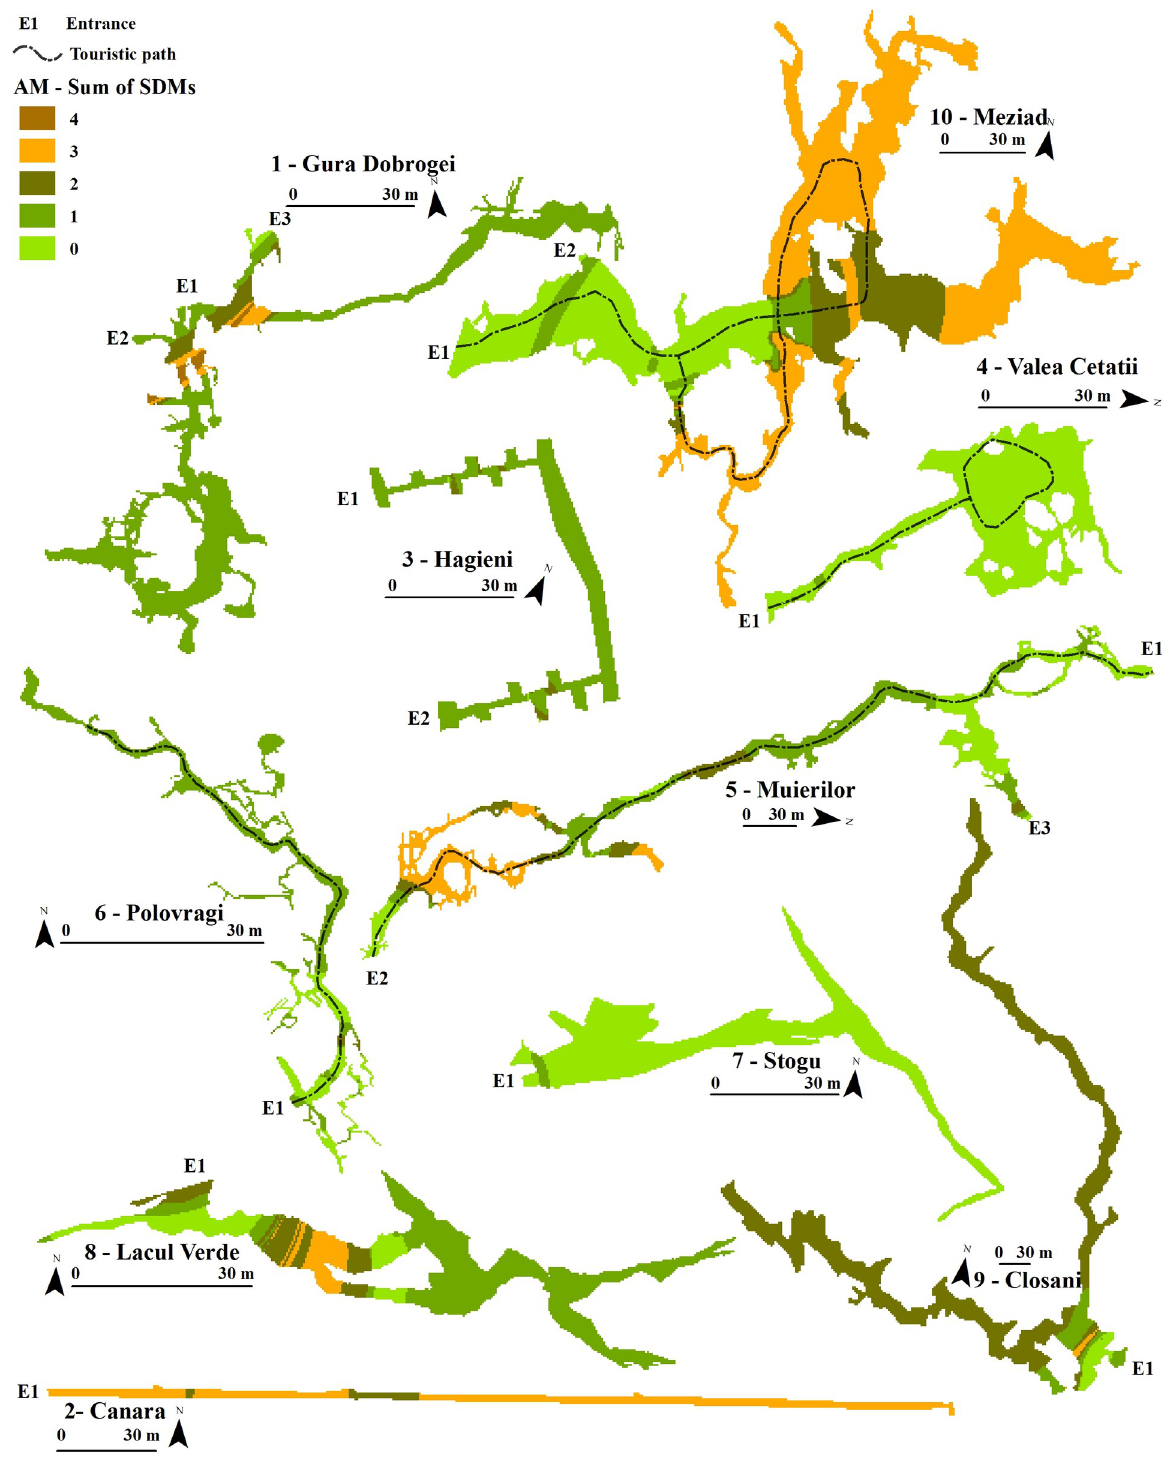
Fig 5. Ensemble SDMs for the April–May (AM)—pre-maternity period for all the studied SEs. Sum of SDMs shows the number of suitable habitats which overlap within a SE.